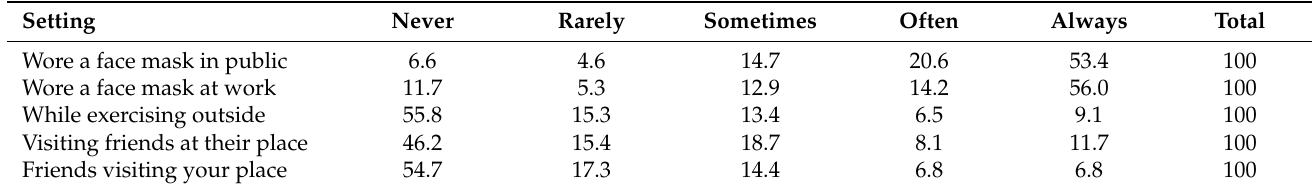
Table 7. Frequency distribution of self-reported wearing of face